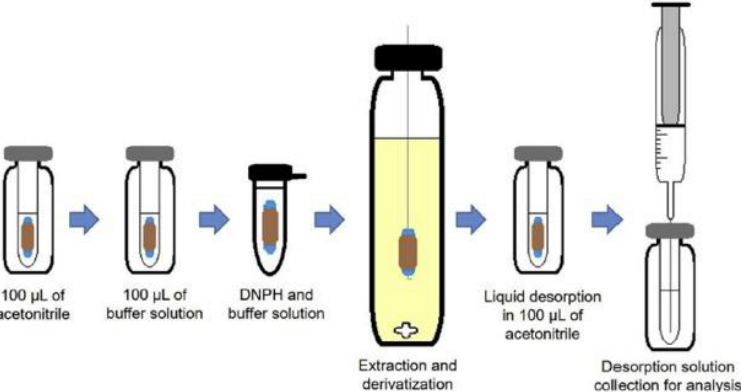
Figure 1. Scheme of the biobased bar-adsorptive microextraction (BAµE) procedure to determine hexanal and heptanal in human urine by HPLC-DAD. Reproduced with permission from [19],